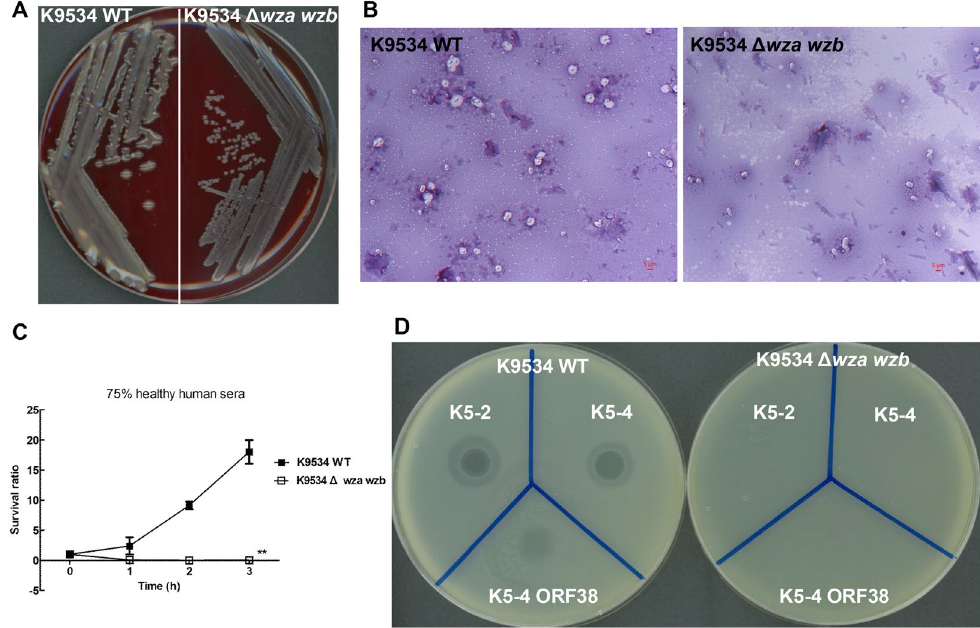
Figure 5. Characteristics of the NTUH-K9534 wild-type and its isogenic capsule deficient strains. ( A ) Differences in the hypermucoid phenotype are observed between the wild-type and its capsule deficient strains on the blood agar. ( B ) Under light microscopy, the wild-type strain K9534 produces an exopolysaccharide web attached to the capsule (original magnification, 1,000). The K9534 wza wzb -deletion mutant loses the capability of producing an exopolysaccharide capsule. ( C ) Serum sensitivity assays of resistance to killing by nonimmune healthy human serum of the K9534 wild-type and its wza wzb -deletion mutant strains. The data represent the means of three independent trials; the error bars represent the standard deviations. A mean survival ratio ≥ 1 corresponds to serum resistance. ** P < 0.01 by Student’s t test (compared to the wild-type strain). ( D ) Spot tests of phages K5-2, K5-4 and the K5-4 ORF38 protein on the K9534 wild-type and its capsule deletion mutant strains. Phages (10 6 PFUs) or 1 μ g K5 depolymerase were spotted on the plate, and a clear spot or a translucent spot, respectively, is